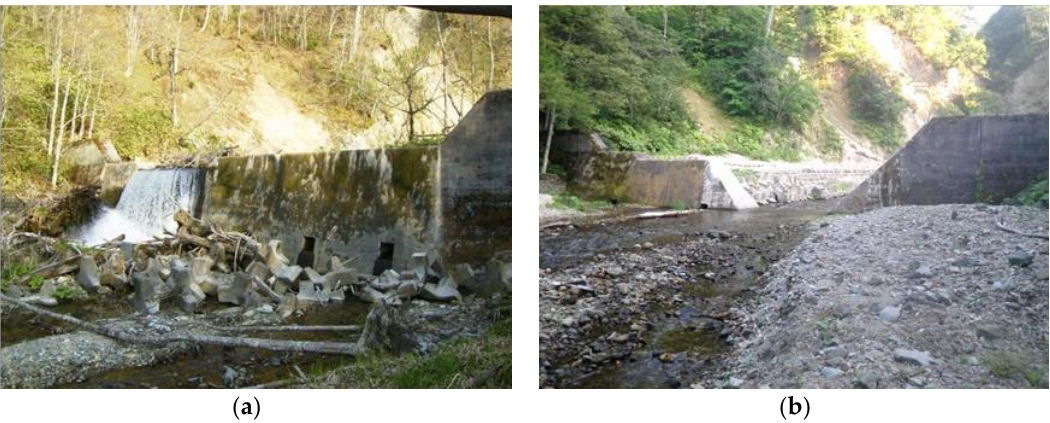
Figure 2. The check dam before ( a ) and after ( b ) the partial dam removal implemented in February 2009.